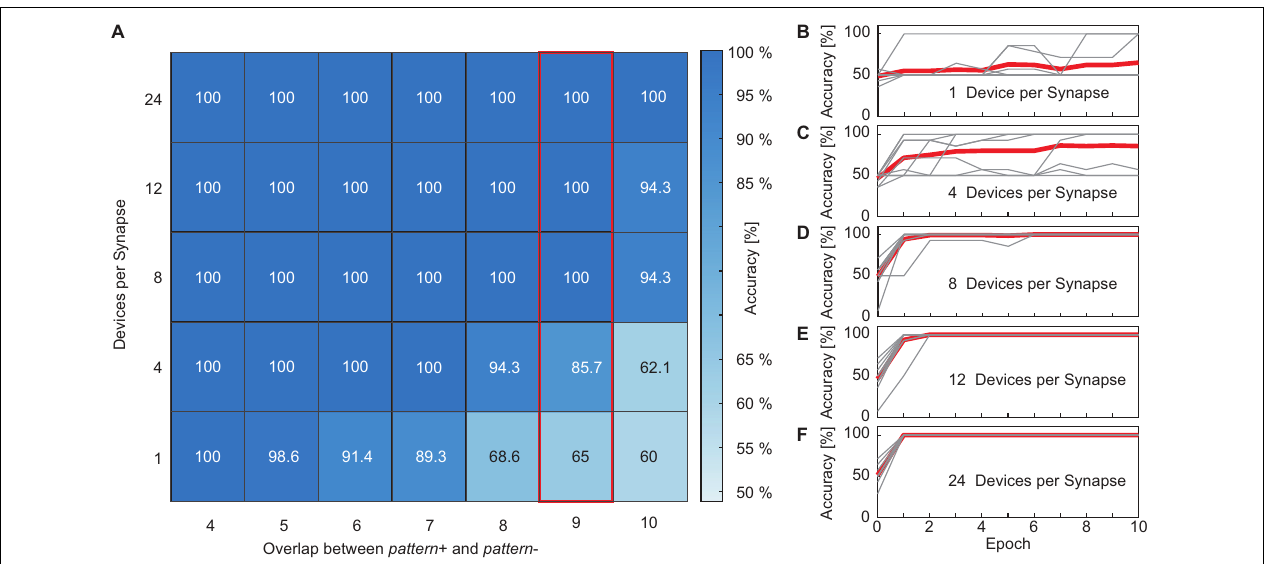
FIGURE 9 | (A) Simulation results of the neural network’s accuracy as a function of the overlap between the patterns and the number of devices per synapse. (B–F) Show the accuracy over the training epochs for all 10 runs (thin gray lines) as well as the mean curve (thick red line) for an overlap between the patterns of nine. (B) Shows the results if each of the 22 synapses consists of only one ReRAM device, (C–F) for 4, 8, 12, and 24 devices per synapse, respectively.